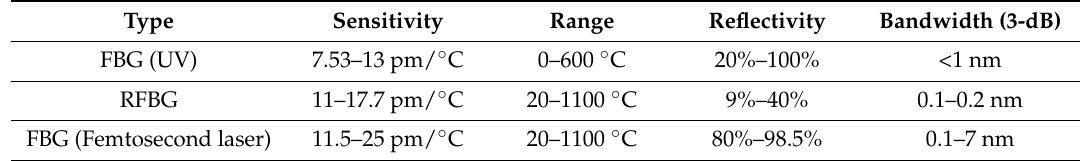
Table 2. FBG-based high temperature sensors